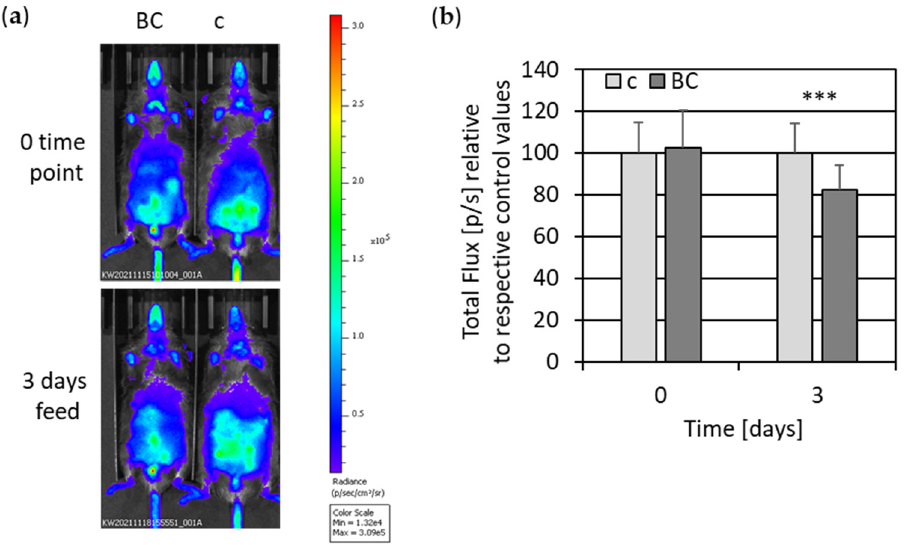
Figure 9. NF- κ B induction measured by in vivo luciferase activity of control- vs. BC-fed mice. ( a ) Representative pictures are shown as bioluminescent images with artificial colors in NF- κ B-luciferase reporter mice. Bioluminescent images were measured 15 min after i.p. injection of the substrate D-luciferin. In vivo imaging of luciferase activity is shown before (0 time point) and upon 3 days’ feeding. Animals received either control food (c) or food supplemented with 15 % bread crust (BC). ( b ) Quantification of in vivo imaging of luciferase activity in NF- κ B-luciferase-reporter mice. Photon emission was determined by IVIS (total Flux [p/s]) and is shown, as a mean with standard deviation relative to respective control values before (0 time point) and upon 3 days’ feeding ( n = 31; c = 13; BC = 18). *** p ≤ 0.001 ( t test) BCE vs. control-fed mice.